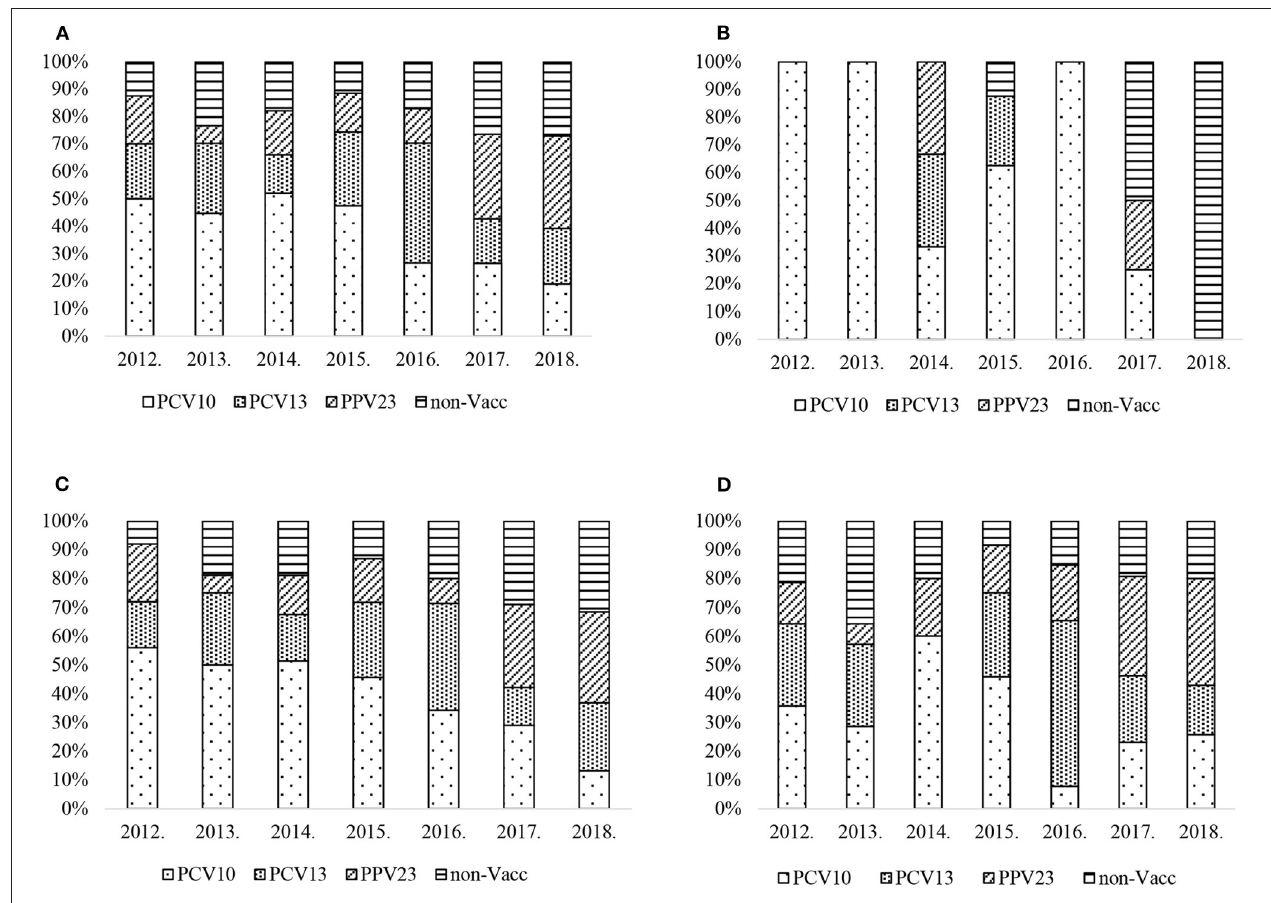
FIGURE 2 | (A) S. pneumoniae serotype percentage by year and PCV vaccine type, all age groups. (B) S. pneumoniae serotype percentage by year and PCV vaccine type, age group < 18. (C) S. pneumoniae serotype percentage by year and PCV vaccine type, age group 18–64. (D) S. pneumoniae serotype percentage by year and PCV vaccine type, age group ≥